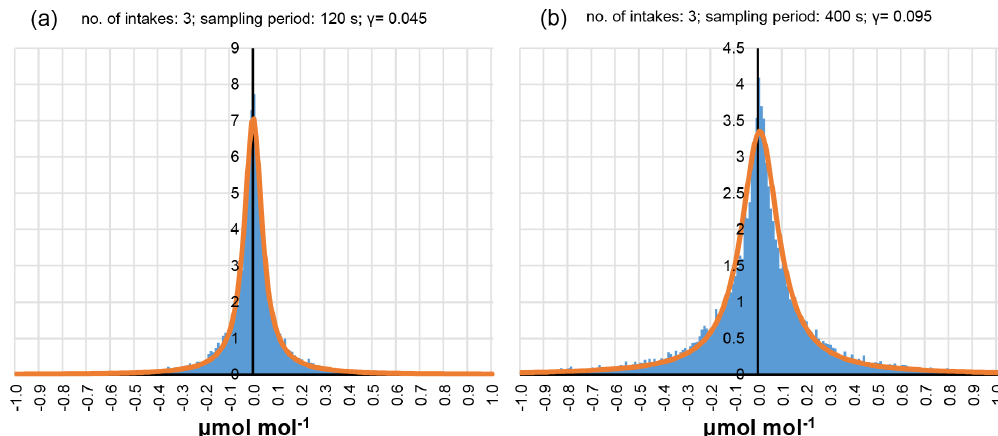
Figure 2. Distribution of the deviations of the hourly averages estimated as the arithmetic average of the available measurements from the true hourly averages for three intakes with 120s (a) and 400s (b) sampling periods. Scale parameters of the fitted Cauchy distribution are 0.045 and 0.095,